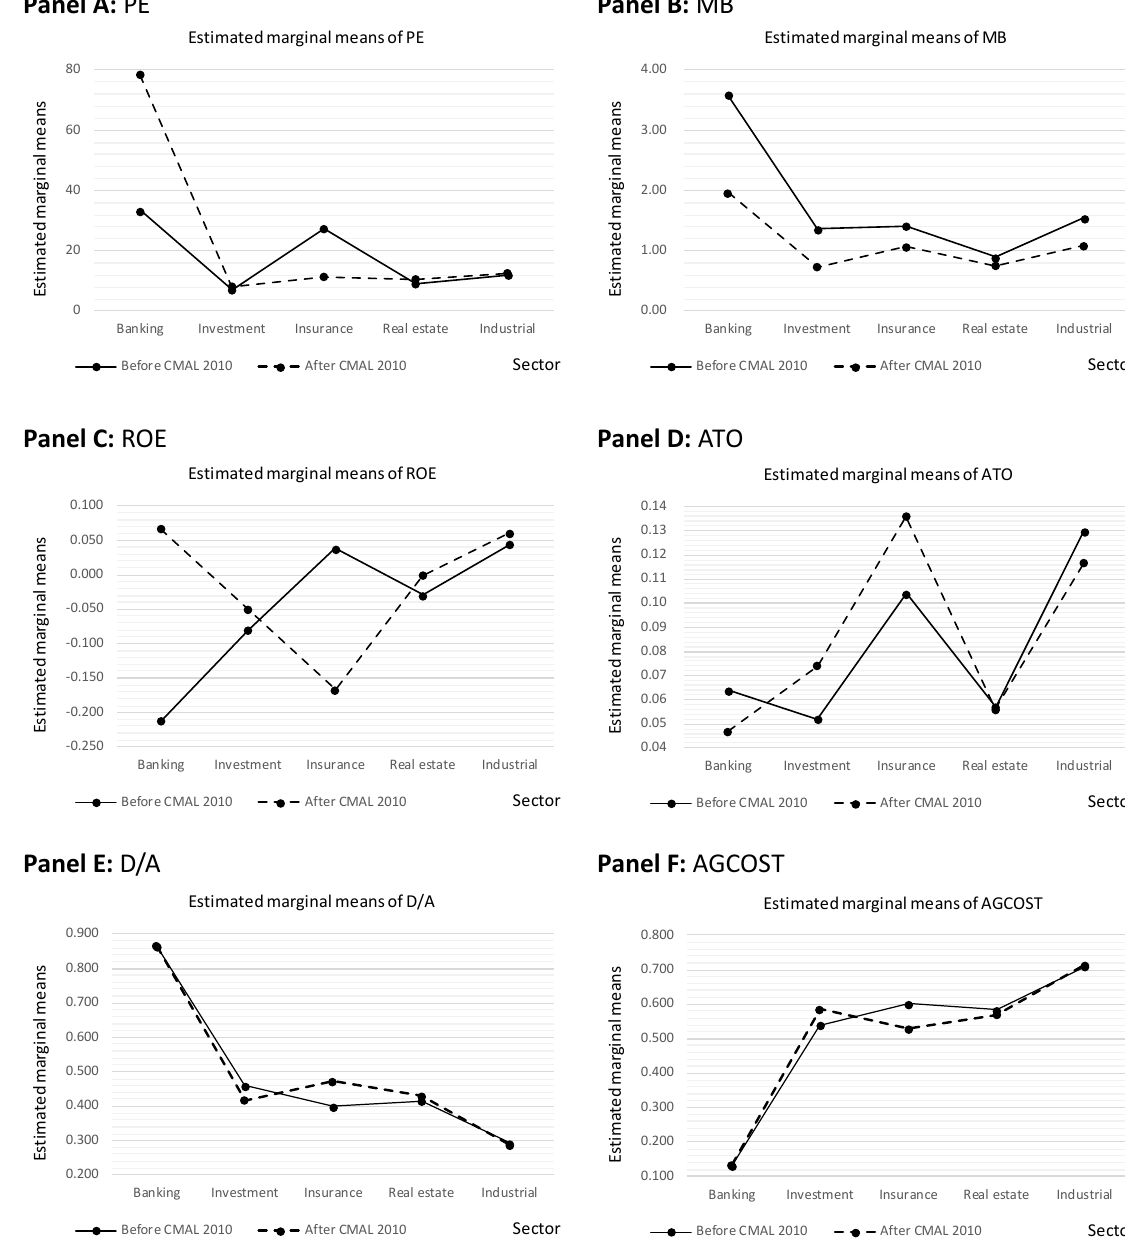
Figure 1. Plot of means before and after CMAL